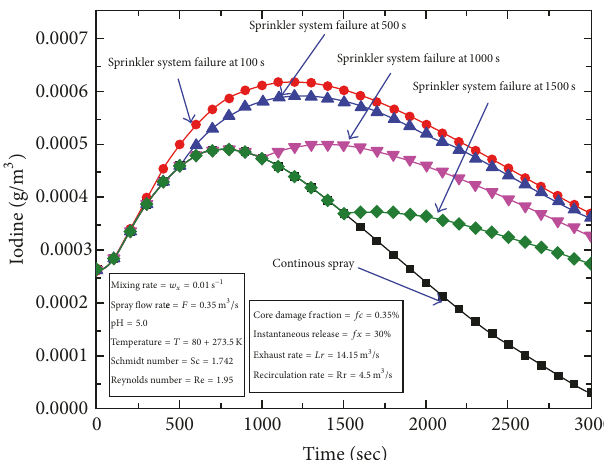
Figure 12: Radioactive iodine with containment spray system failures during in-vessel release phase with mixing rate 𝑤 푥 = 0.01 s −1 .